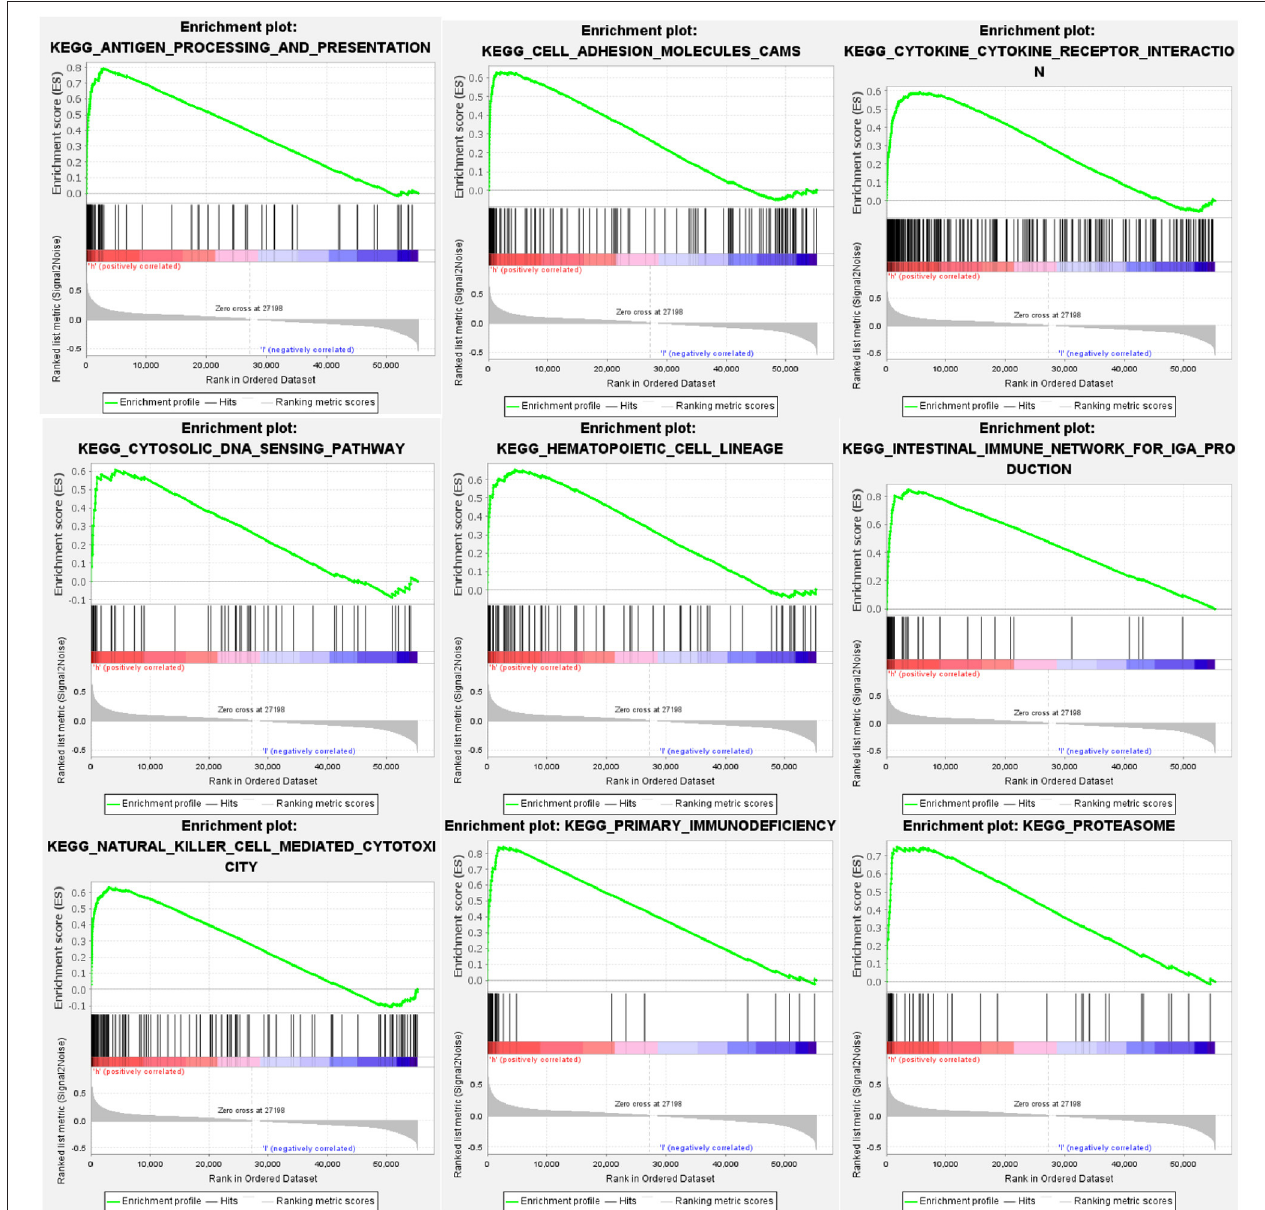
FIGURE 8 | GSEA identification of HCST-related signaling pathways in ccRCC. GSEA pathways enriched in samples with high HCST expression. The GSEA results showed that the terms “proteasome,” “cytosolic DNA sensing pathway,” “cell adhesion molecules cams,” “cytokine receptor interaction,” “primary immunodeficiency,” “hematopoietic cell lineage,” “natural killer cell-mediated cytotoxicity,” “intestinal immune network for IGA production,” and “antigen processing and presentation” were differentially enriched in GC samples with high BICC1. NES, normalized enrichment score.